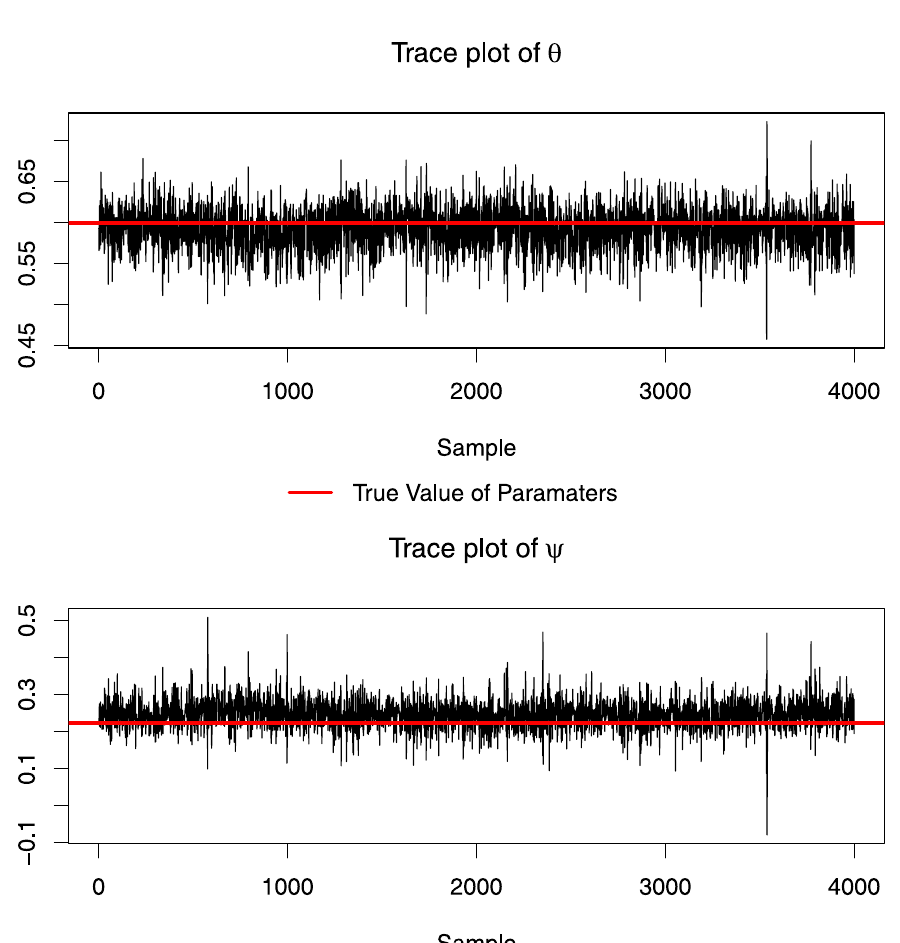
Fig 5. Trace plot of AR and MA parameters. Both parameters converged to the true